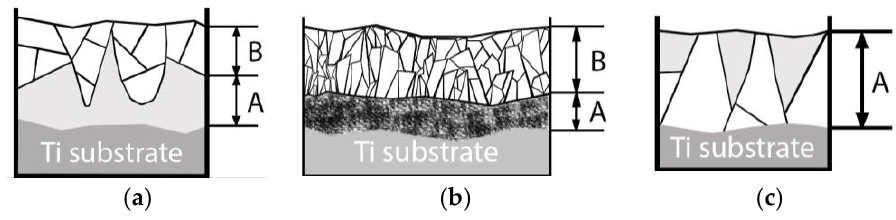
Figure 14. Schematic illustration of CaP microstructure after HT at 450 °C ( a ), HT at 700 °C ( b ), and in situ substrate heating to 400 °C ( c ).